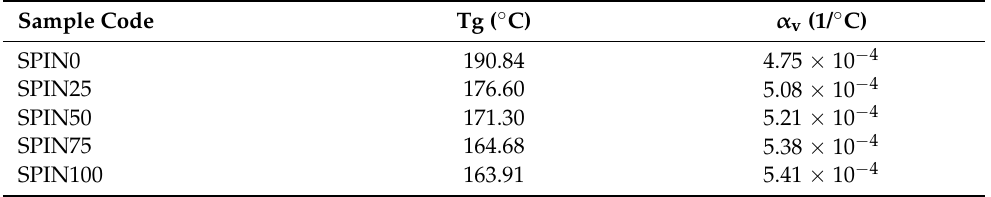
Table 3. Thermal properties of the analyzed PI-based supramolecular systems: glass transition temperature (Tg) and thermal expansion ( α v